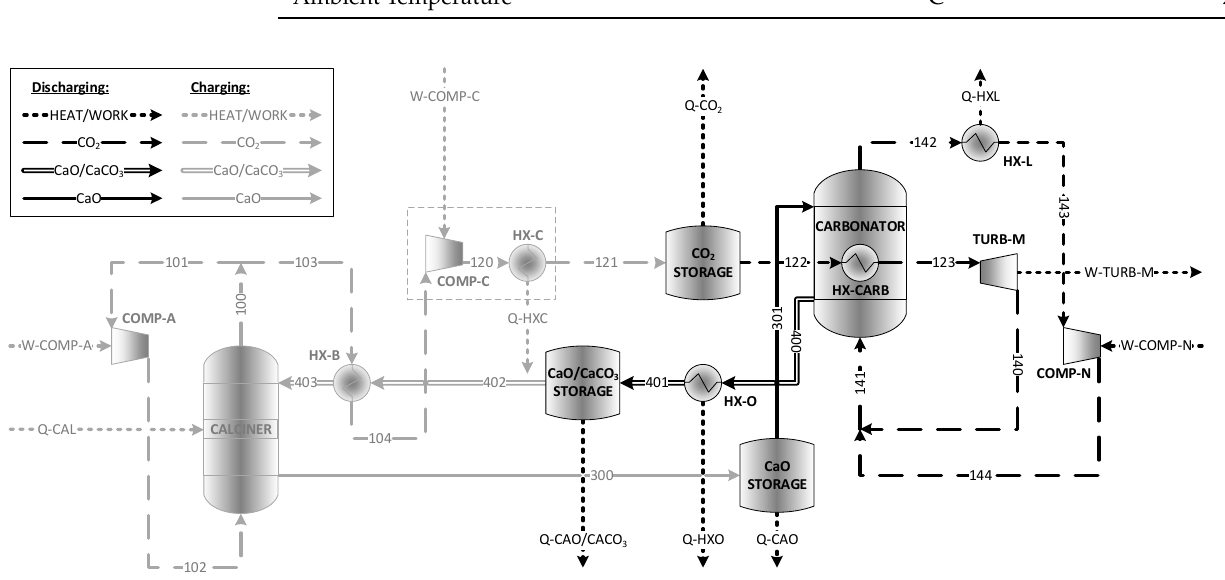
Figure 2. Process flow diagram for Configuration 1; Hot CaO storage and cold CaO/CaCO 3 storage.